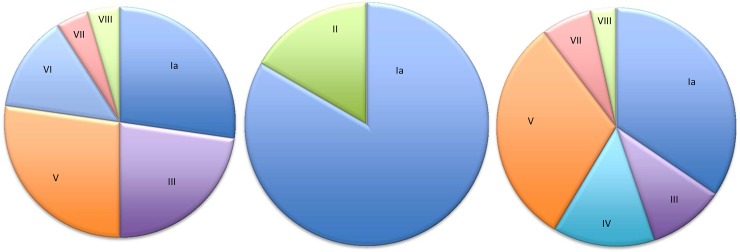
Distribution of GBS capsular serotypes.Left, Kenya (n = 22); middle, Rwanda (n = 6); right, South Africa (n = 29).